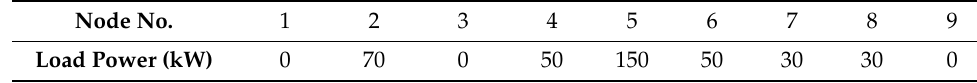
Table A2. 100% Thermal Power Subsystem